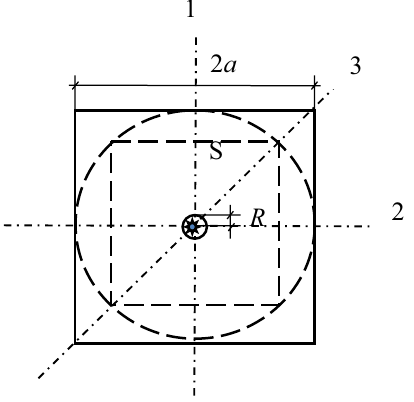
Figure 1. Calculation sketch partition of the reinforced concrete